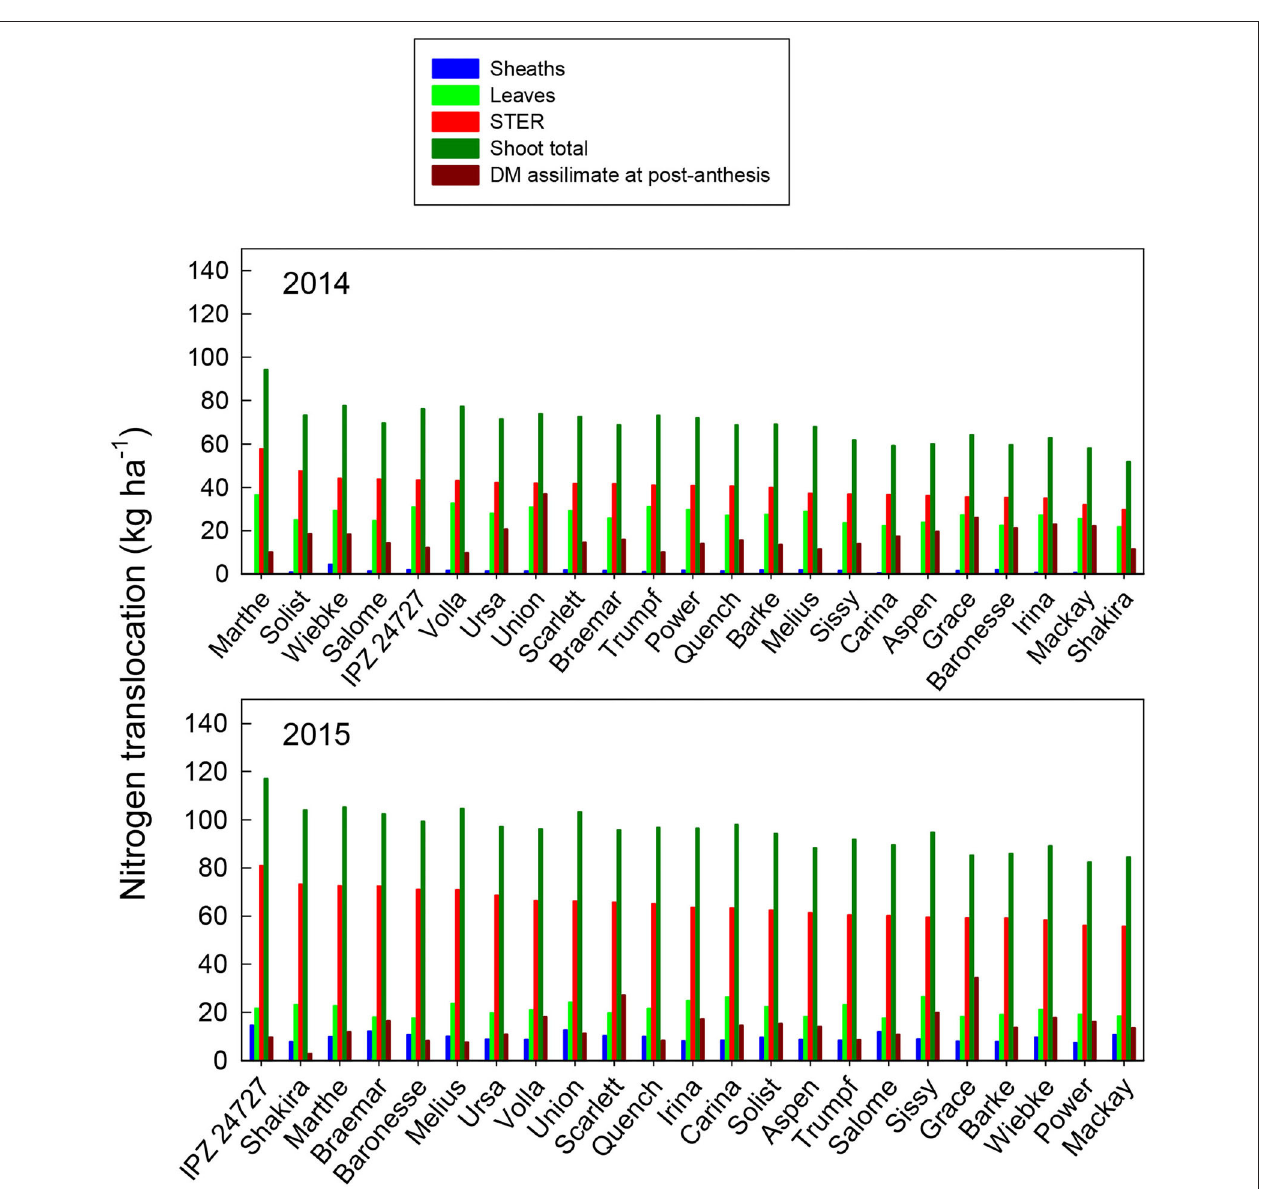
FIGURE 5 | Nitrogen translocation from different organs: N translocation (kg ha − 1 ) of different plant organs of the 23 spring malting barley varieties to grain from pre-anthesis and maturity under recommended N fertilization conditions in 2014 and 2015, ranked on N translocation of STER. Mean comparisons among varieties from Tukey’s HSD test are shown in Supplementary Tables 6 and 8